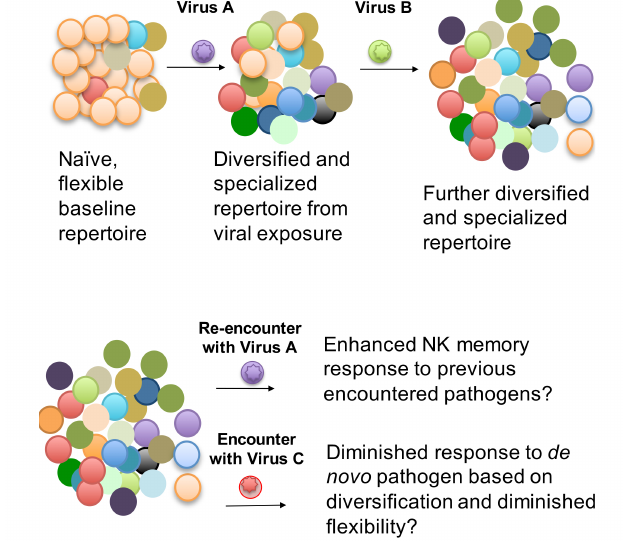
Figure 1. Proposed model of the relationship between NK cell diversity and viral exposure. Based on the association between age, immune experience, and NK cell diversity, I propose that the NK cell repertoire begins as a naïve, flexible repertoire that is relatively homogenous from a phenotypic perspective, though it has extensive diversity in KIR expression patterns based on genetics. Upon encounter with different viruses, the NK cell repertoire diversifies, in part by increasing expression levels of activating receptors, as it seeks to adapt to the viral encounter. Each subsequent encounter further diversifies and specializes the repertoire. This specialization might contribute to memory/recall responses, but may also have the surpris- ing effect of diminishing the ability to respond to de novo pathogens. Vaccine and viral challenge studies in human and animal models will be needed to validate or invalidate this